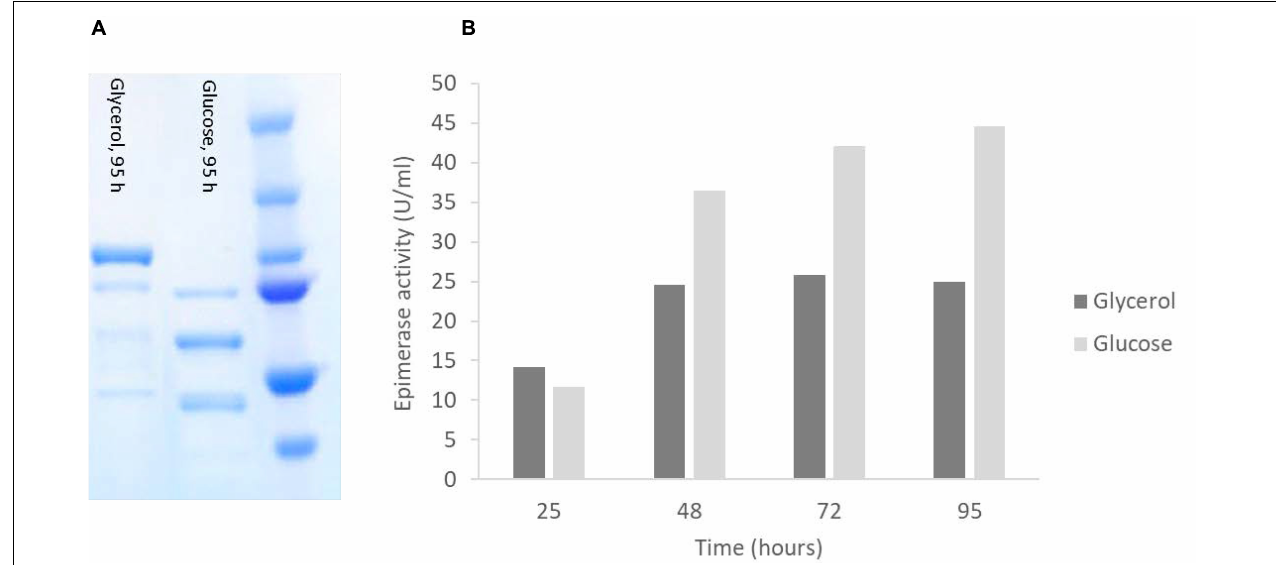
FIGURE 7 | SDS-PAGE analysis (A) and epimerase activity (U/ml culture) (B) of RB11/algE6syn cultivated in 2xYSPG with glycerol in the basis medium and a feeding solution composed of 60% glycerol, or in 2xYSPG + 1/3 HCD (glucose in basis medium) and feeding solution composed of glucose (60%) and methanol (10% of glucose). Samples for activity analysis was taken at 25, 48, 72, and 95 h. SDS-PAGE show the AlgE6 content in the samples taken at 95 h. Size of protein fragments in standard (right); 250, 150 100, 75, 50, and 37